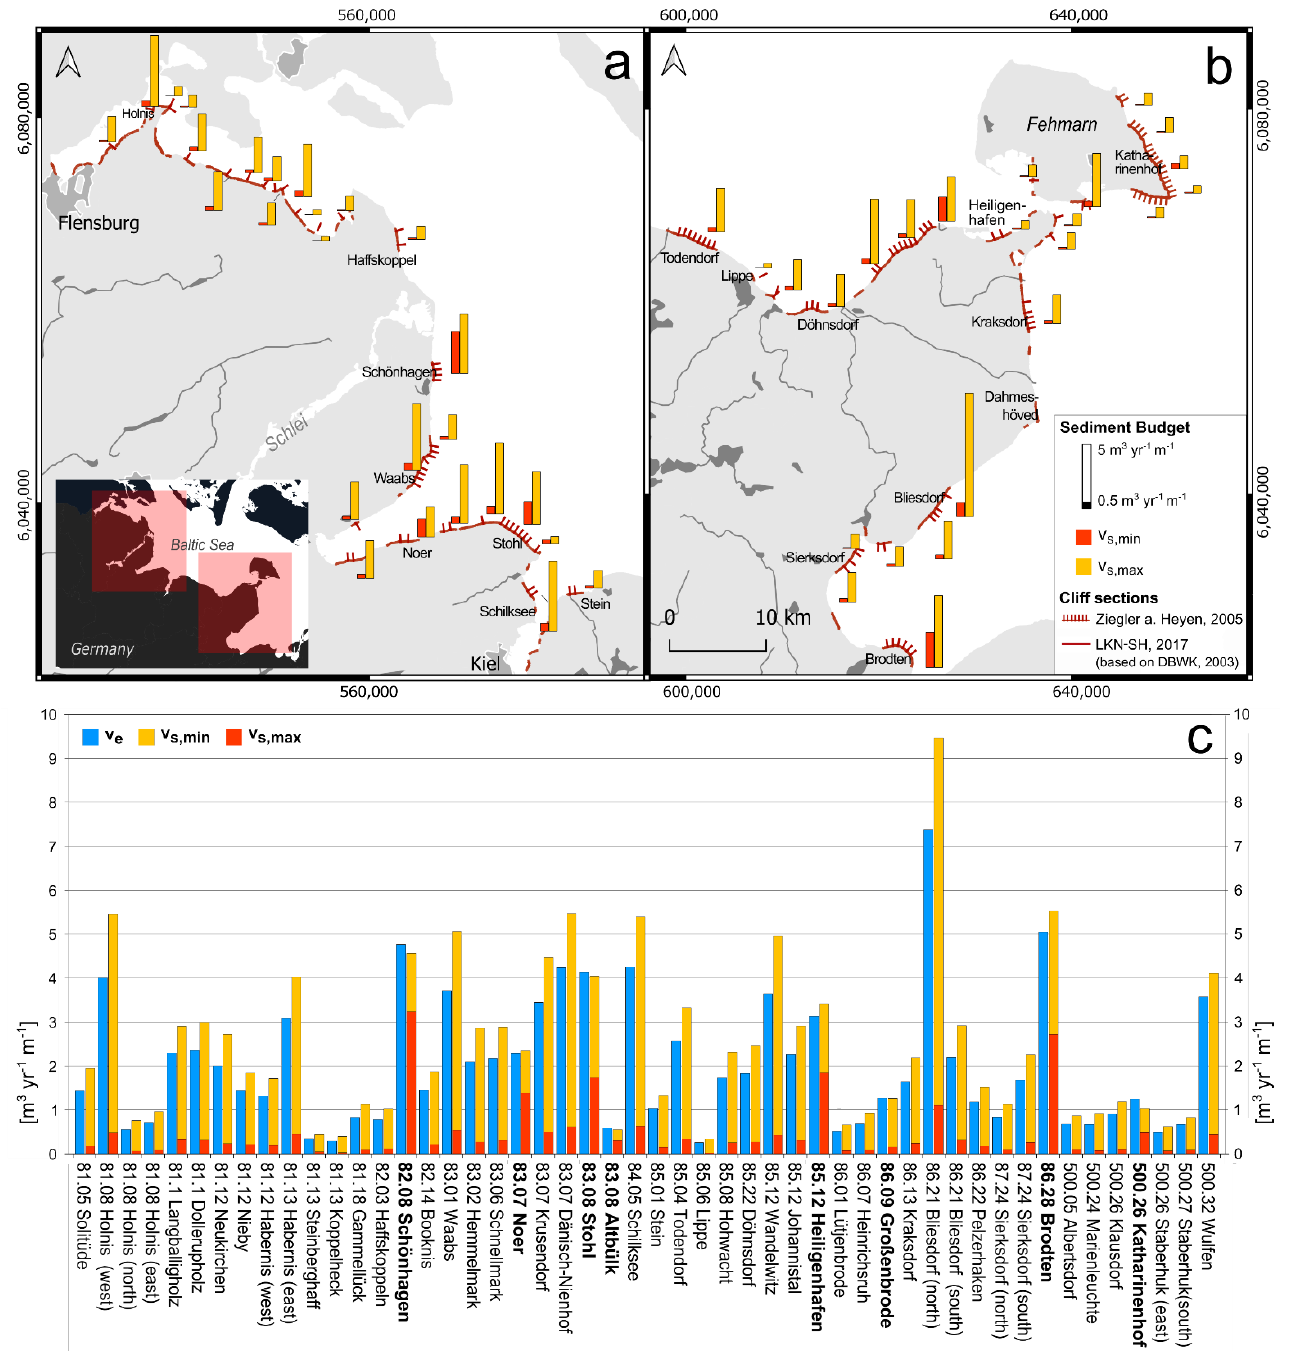
Figure 5. ( a , b ) Maps showing the calculated littoral sediment budget, v s,min (orange) to v s,max (yellow), for the local cliff sections; ( c ) comparison of the specific values of the erosional volume v e (blue) [36] and the littoral sediment budget v s,min (orange) to v s,max (yellow). Bold labels represent results based on available local data (Figure 4); all other results are based on derived estimates (Table 2).